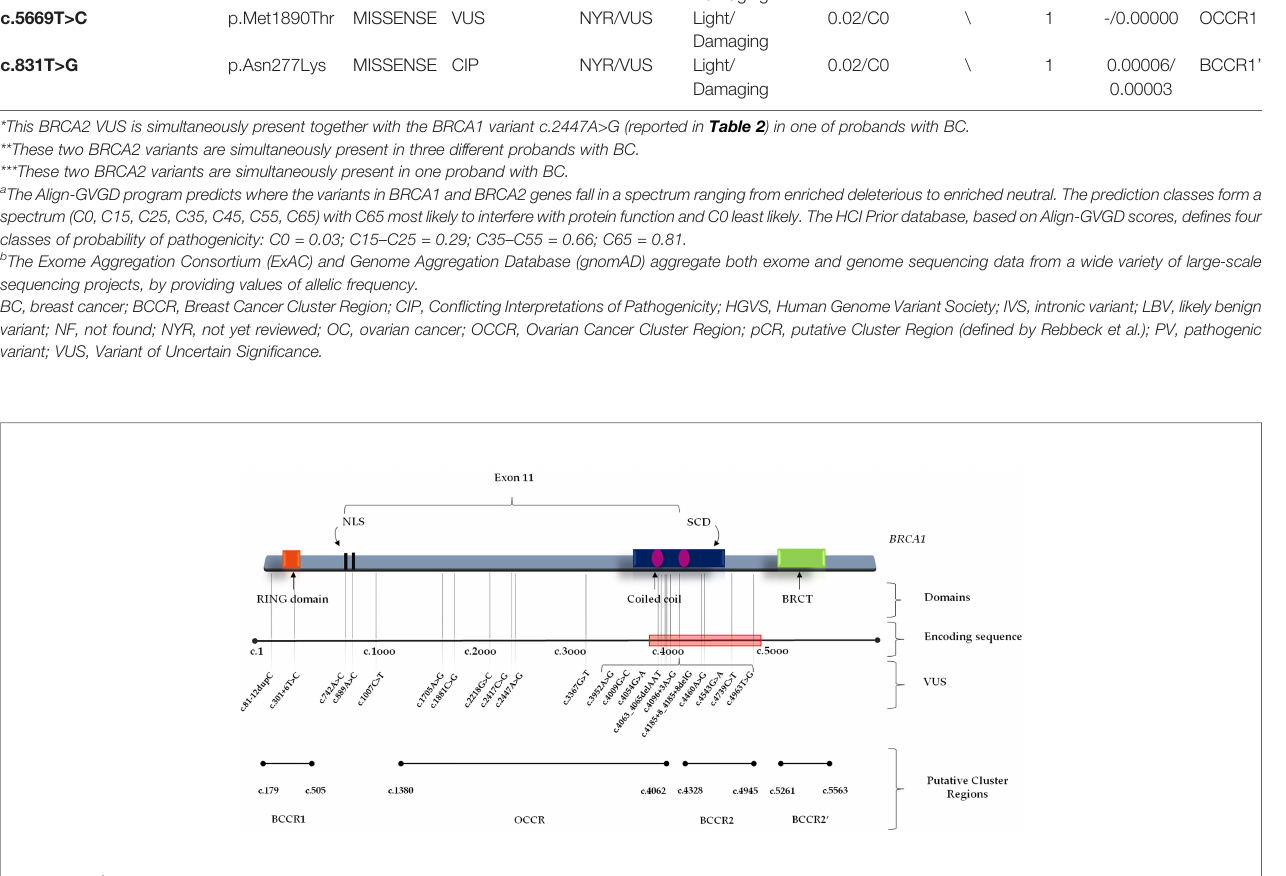
FIGURE 1 | BRCA1 functional domainsandgene location of BRCA1 Variants ofUncertainSigni fi cance in BC and/or OC patients. BCCR, Breast Cancer Cluster Region; BRCT, BRCA1 C-terminusdomain; NLS, nuclear localization sequence; OCCR,Ovarian Cancer Cluster Region;SCD,serine cluster domain; VUS, Variant of Uncertain Signi fi